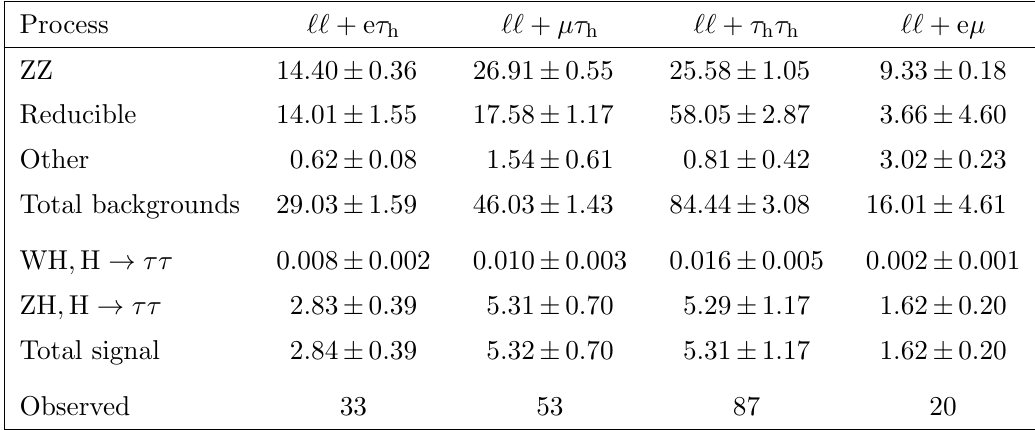
Other Total backgrounds